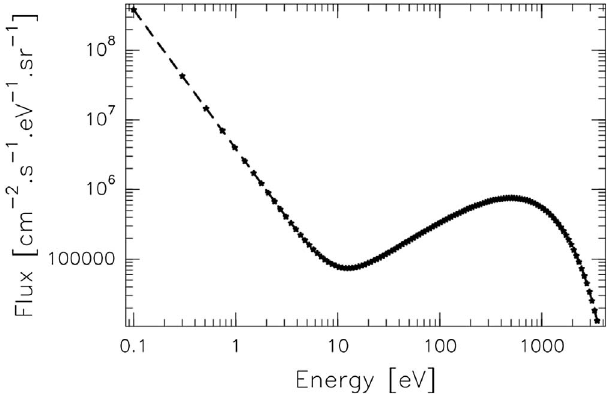
Fig. 8. Electron precipitations for a mean energy E o = 500 eV and a total energy E tot = 5 erg.